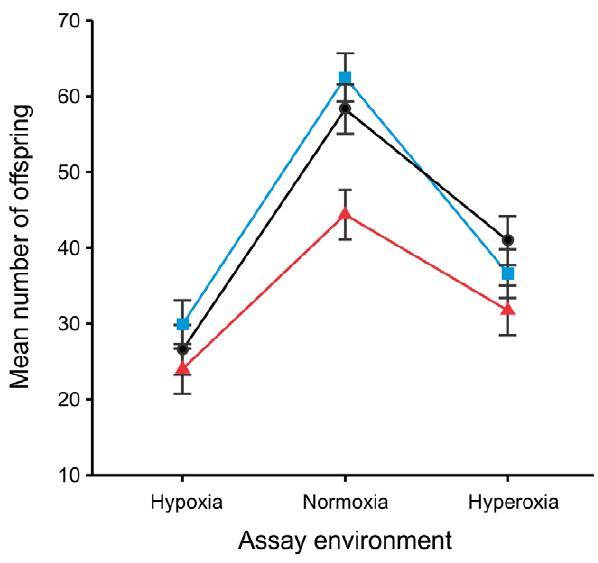
Figure 3. Productivity as measured in a reciprocal transplant among treatment environments at generations 35–36(30–31 hyperoxia). Productivity, measured as the number of adult offspring produced by a male-female pair after 14 days, in D. melanogaster populations evolved under normoxic (black circles), hypoxic (blue squares) and hyperoxic (red triangles) treatment environments and then assayed under hypoxic, normoxic, and hyperoxic environmental conditions. All populations were raised in a common normoxic environment for two generations prior to conducting the assay. The main effects of assay environment (p , 0.001) and treatment (p=0.022) and were significant, but not their interaction (p=0.186). Post-hoc analyses reveal significant differences among all three assay environ- ments, and a significantly reduced productivity in the hyperoxia treatment relative to the other two.